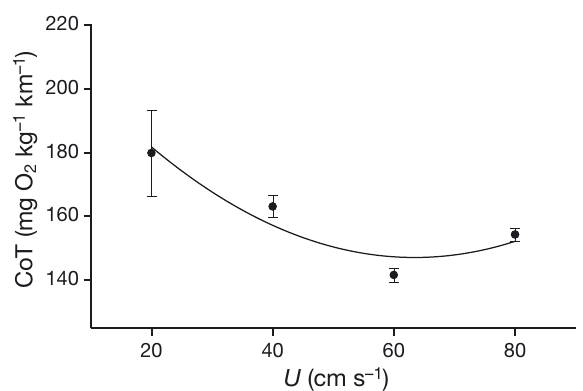
Fig. 3. Cost of transport (CoT) at intermediate swimming speeds calculated from the critical swimming speed ( U crit ) trials (n = 3) for Atlantic salmon. The parabola fit is y = 0.019 x 2 − 2.333 x + 221, R 2 = 0.903, and the minimum is 147 mg O 2 kg −1 km −1 at 63.3 cm s −1 , which marks the theo- retical optimum CoT. Data are means ±